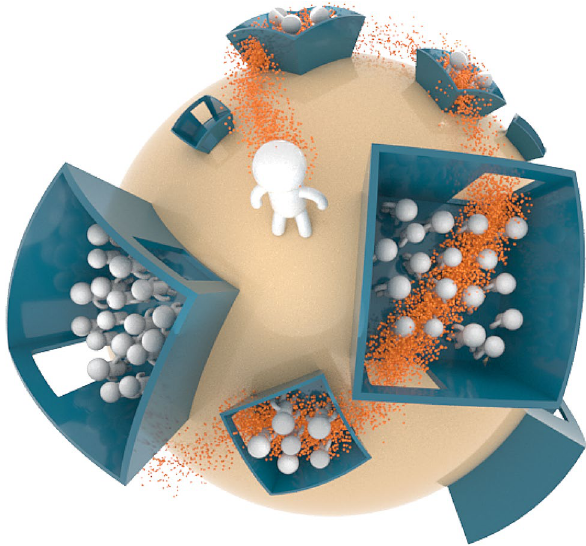
Figure 1. Illustration of model world. An infectious person visits M places while being infectious, at each visit spreading airborne pathogens that can infect many. The number of people that can potentially be infected at each location depends both on the size of the location and the range of spread of the airborne